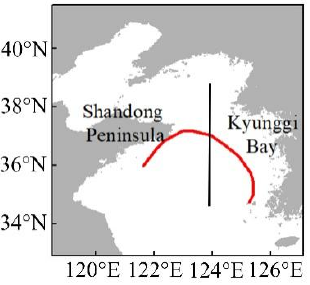
Figure 10. Red line, the location of the YSRF; black line, demarcation line between the eastern frontal